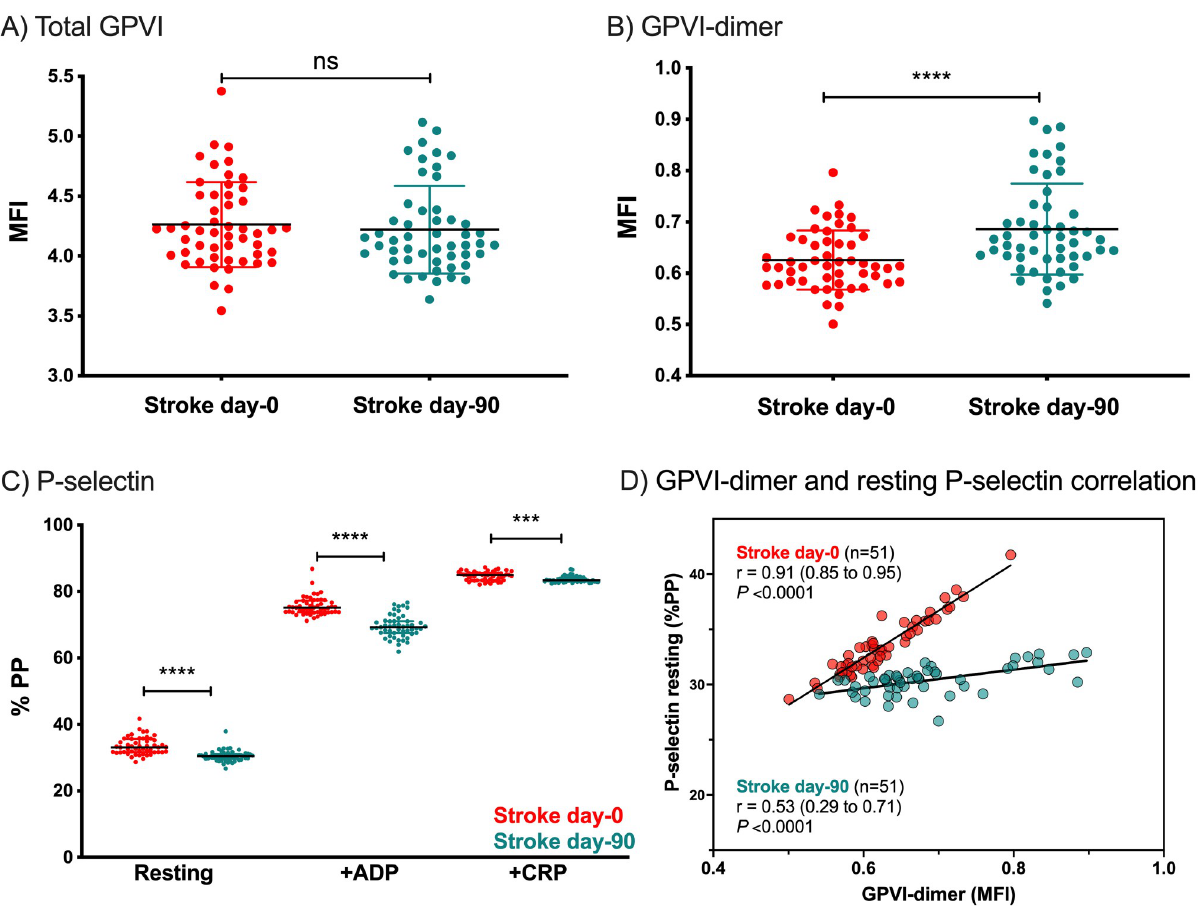
Fig 3. Comparison of GPVI expression and P-selectin exposure in stroke patients at day-0 and at day-90 (n = 51). A) Total GPVI expression is not different at day-90 compared to day-0 ( P = 0.52). B) GPVI-dimer is significantly higher at day-90 compared to day-0 ( P < 0.0001). The error bars represent the mean MFI of each of the cohorts ± SD and P -values were calculated by a paired t-test. C) Resting P-selectin exposure ( P < 0.0001), P- selectin exposure induced by 0.5 μ M ADP ( P < 0.0001), and P-selectin exposure induced by 4 μ g/mL CRP-XL ( P = 0.001) are all significantly lower at day-90. The error bars represent the median (Q1–Q3) %PP of each of the cohorts and P -values were calculated by the Wilcoxon signed-rank test for non-parametric data. ns = not significant. D) Comparison of P-selectin expressed on the platelet surface of stroke patients at day-0 and at day-90 after stroke and P-selectin of resting normal platelets. The P-selectin exposure on stroke patients at day-0 are strongly correlated to GPVI-dimer expression ( P < 0.0001) and higher than those of resting control platelets. By day-90, the stroke patients’ P-selectin exposure, albeit still correlated with GPVI- dimer level ( P < 0.0001), has decreased. Correlations were calculated using Spearman’s rank correlation coefficient and regression line is presented for each data set. MFI = mean fluorescent intensity, %PP = percentage of platelets positive.